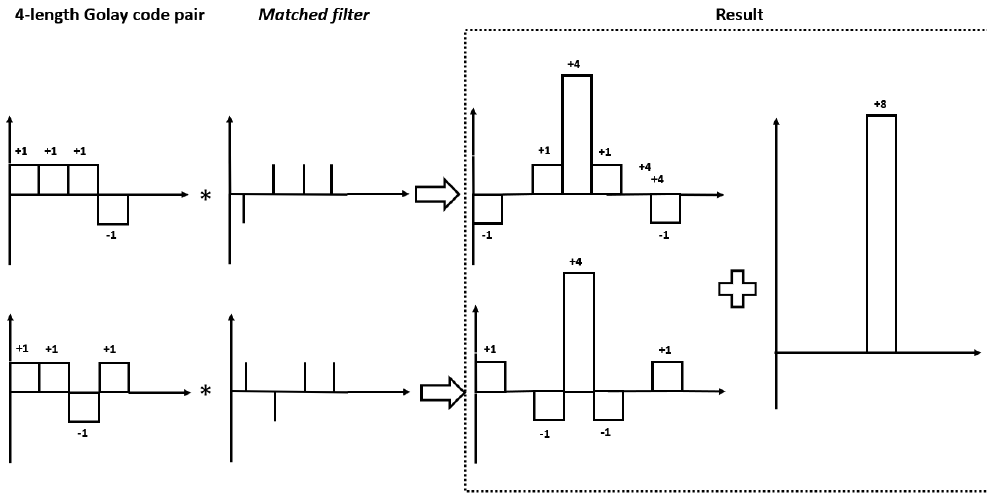
Figure 2. A pulse compression example of a 4-bit Golay code